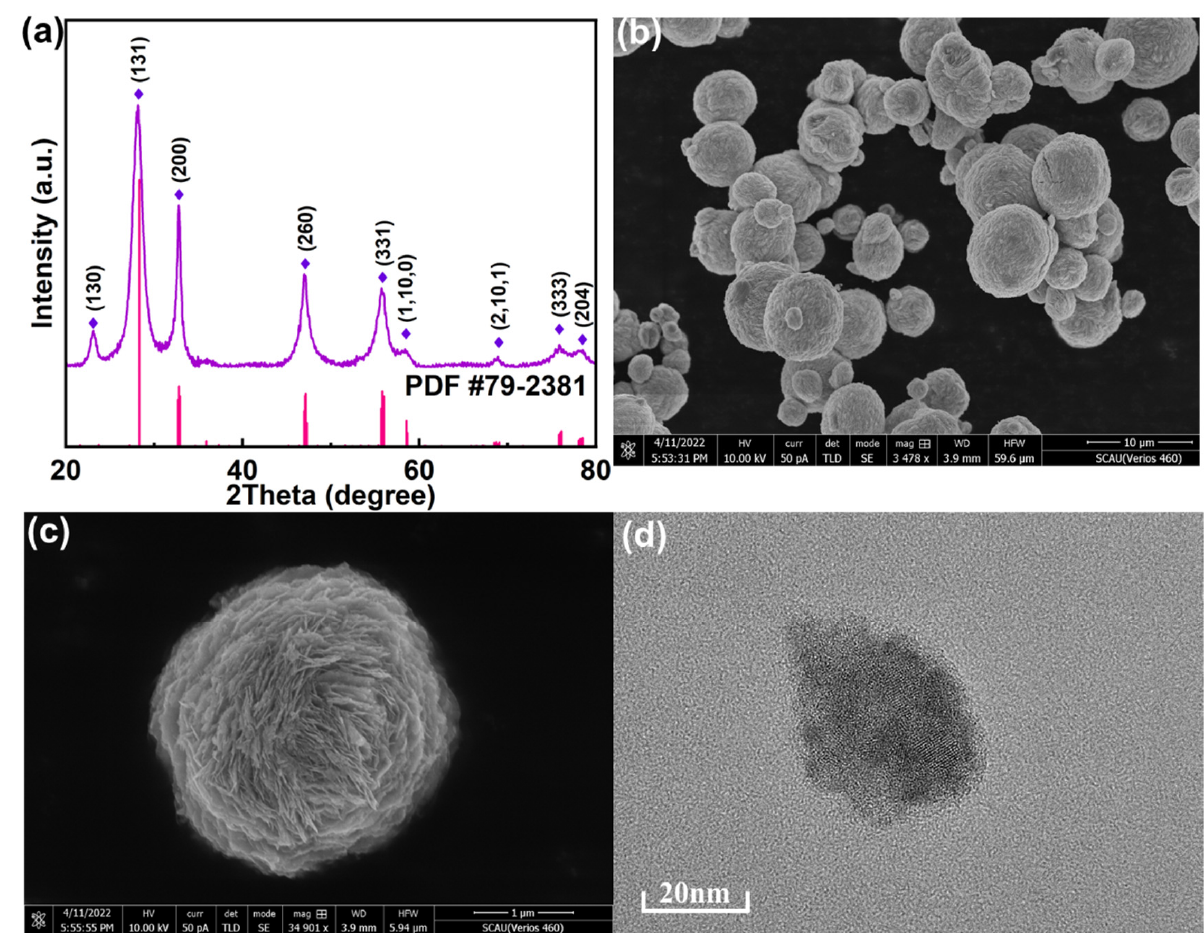
Figure 1. Typical XRD pattern ( a ), FESEM micrographs of Bi 2 WO 6 flower core-structure ( b , c ), and TEM images of Bi 2 WO 6 ( d ).